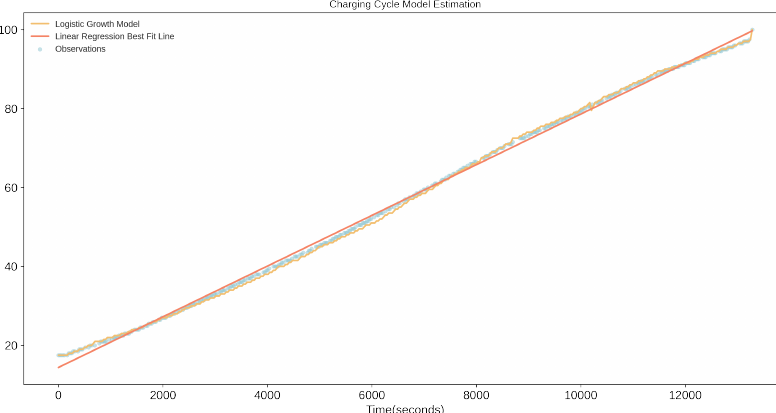
Figure 10. Graph showing SOC of battery over a data collection period.